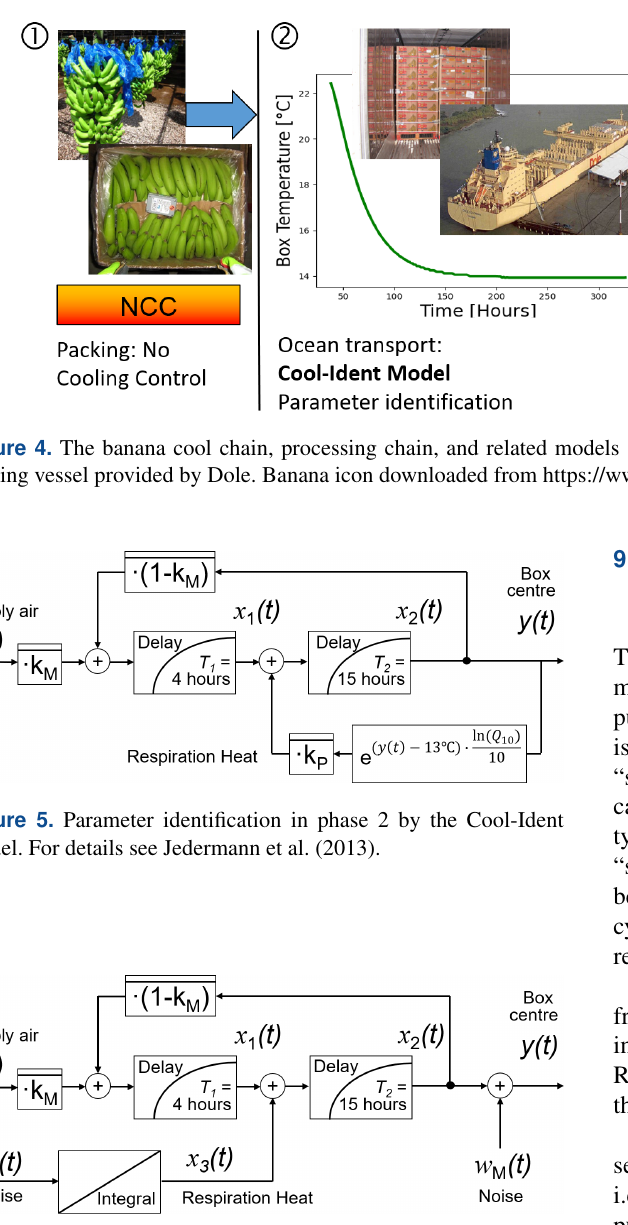
Figure 6. Modified Ripening model for estimation of ripening heat during phase 4. For details, see Jedermann and Lang